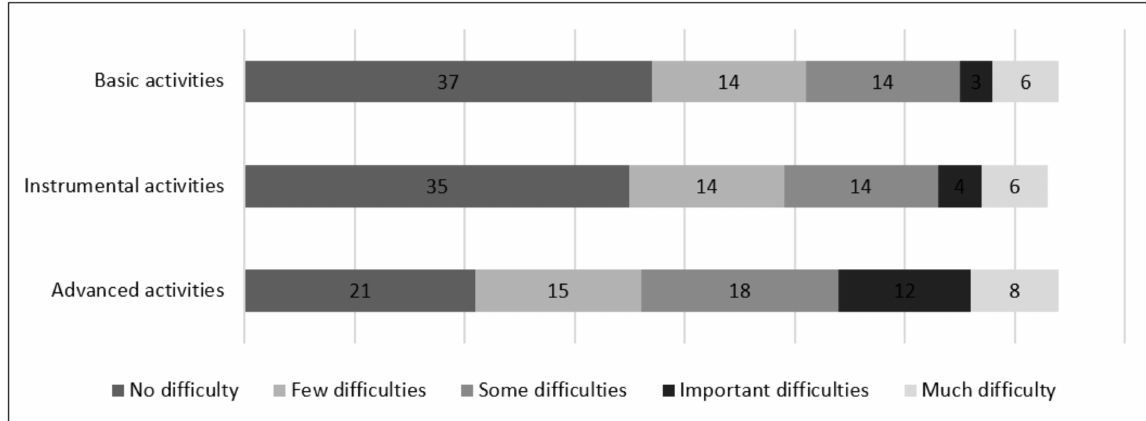
Figure 2. Global performance of activities of daily